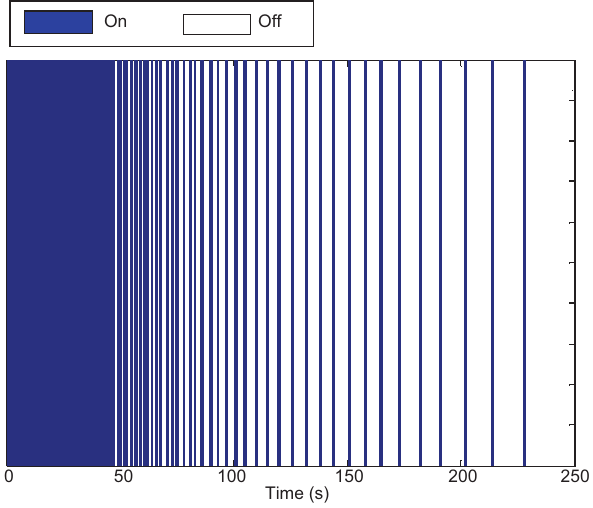
Figure 5 Simulated duty cycle of one